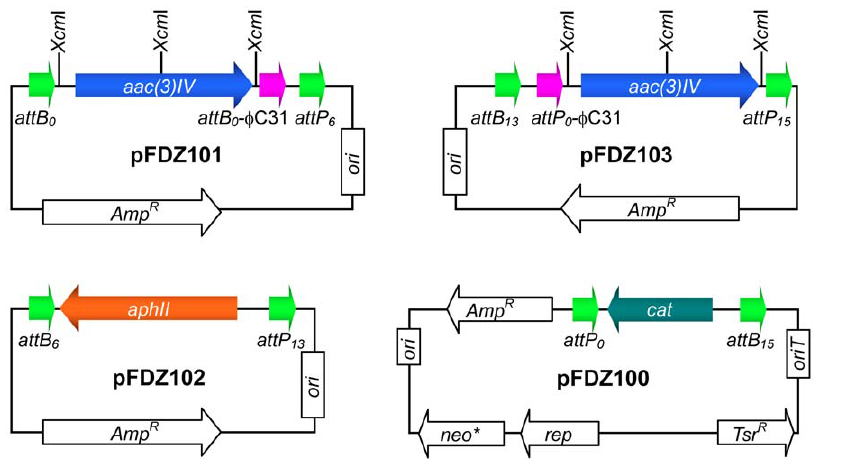
Figure 1. Map of four ‘entry vectors’ used in this study. Plasmids pFDZ101 and pFDZ103 were used to harbor the 5 9 -arm and 3 9 -arm respectively, and pFDZ102 contained the selectable marker ( aphII gene). pFDZ100 was the backbone of the gene-targeting vector. Each vector contained a pair of non-compatible recombination w BT1 integration sites (arrows in green). The pink arrows represent the recombination w C31 integration sites, where recombination occurred to remove the marker gene.